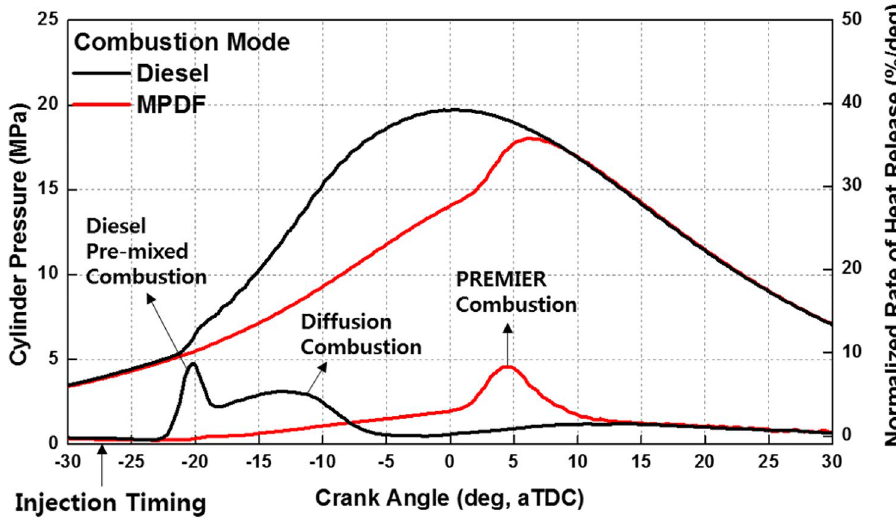
Figure 4. Cylinder pressure and normalized rate of heat release for diesel and MPDF combustion.